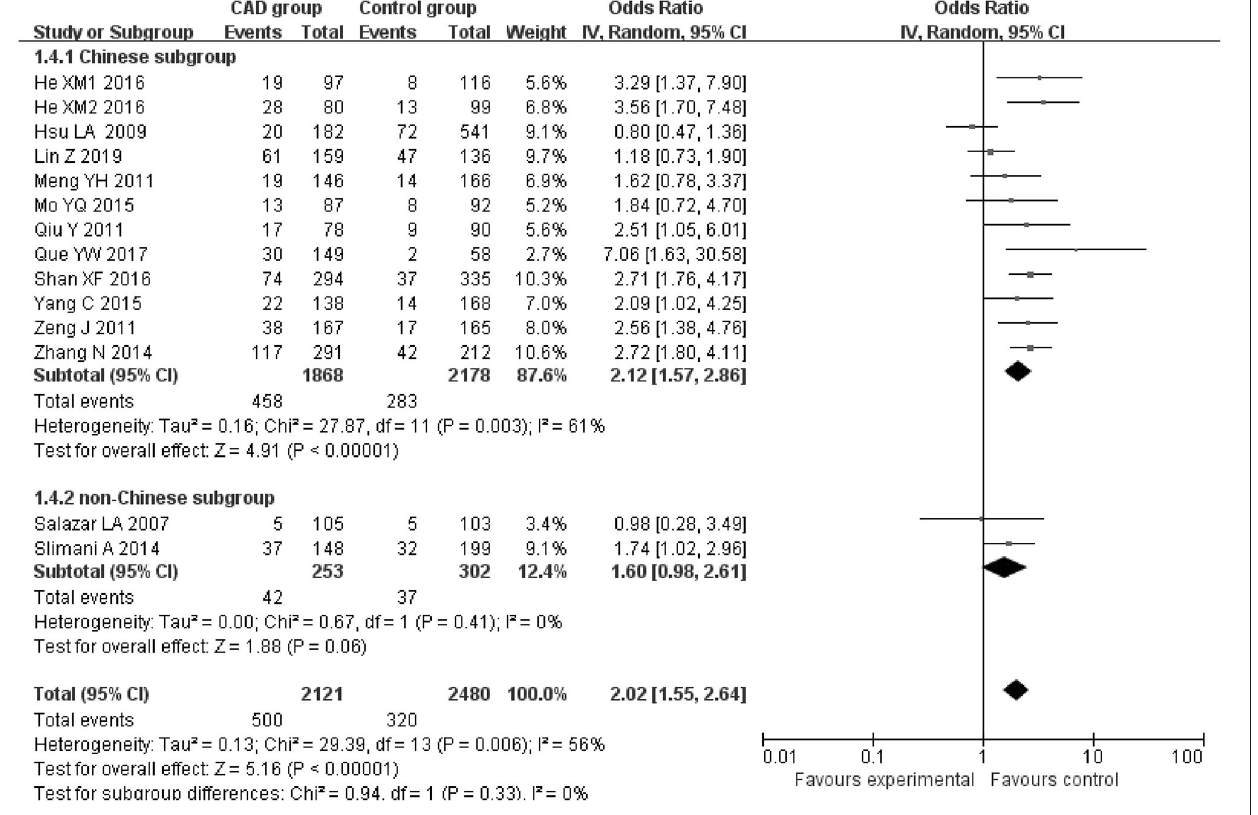
FIGURE 3 | Forest plot of CAD associated with PCSK9 gene E670G polymorphism under a heterozygous genetic model (AG vs.